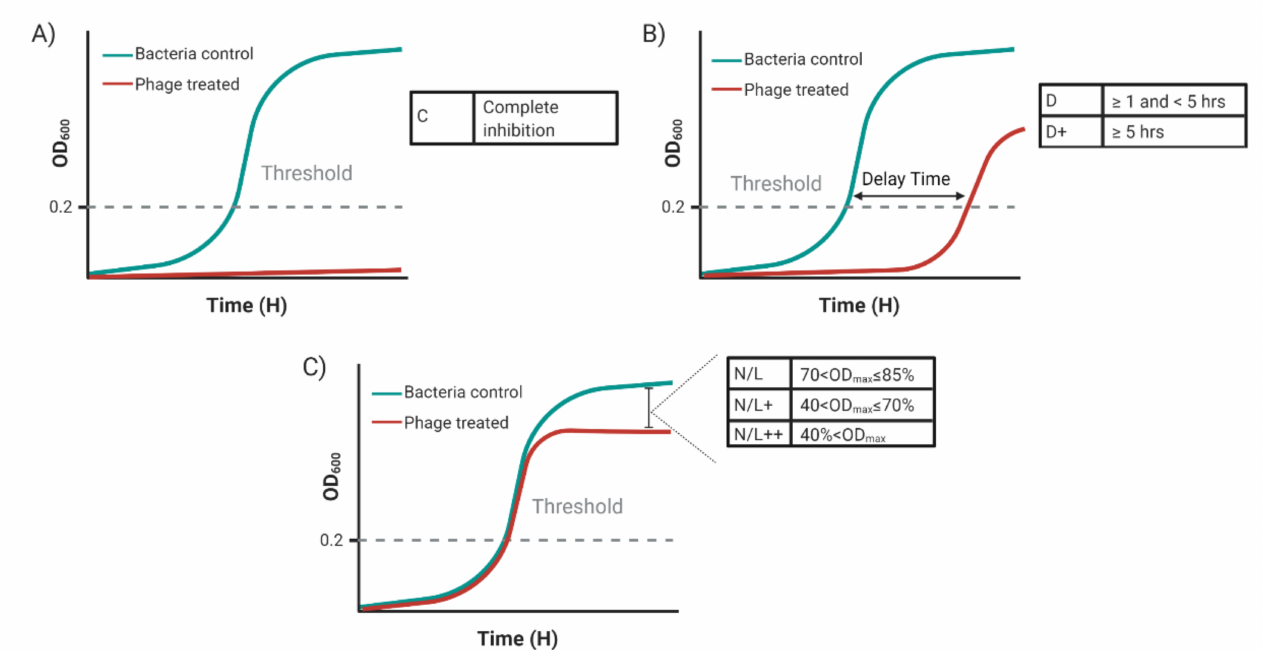
Figure 3. Growth inhibition designations for host range characterization. ( A ) Complete inhibition of the bacterial growth; C : sample never reaches detection threshold for the duration of the experiment. ( B ) More than 5 h delay in bacterial growth compared to control; D+ : time difference to reach detection threshold between sample and control is ≥ 5 h and <“experiment duration time–detection time of the control”. Less than 5 h delay in bacterial growth compared to control D : time difference to reach detection threshold between sample and control is ≥ 1 and <5 h). ( C ) Time difference to reach detection threshold between sample and control is <1 h. Small effect on bacterial growth endpoint; N/L : OD max is 70–85% of control. Moderate effect on bacterial growth endpoint; N/L+ : OD max is 40–70% of control. Large effect on bacterial growth endpoint N/L++ : OD max is ≤ 40% of control. Created with